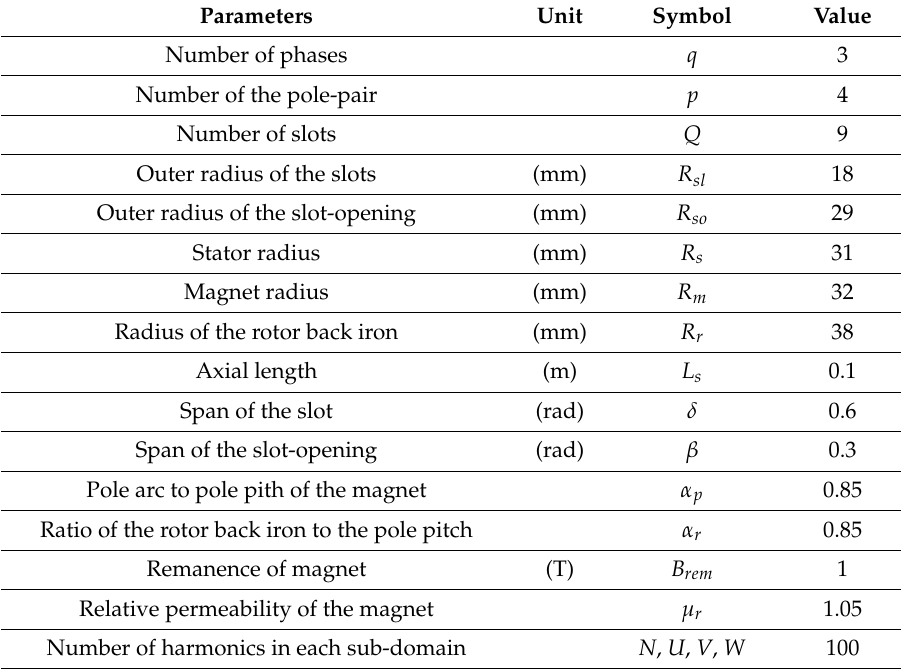
Table 3. Parameters used in the case